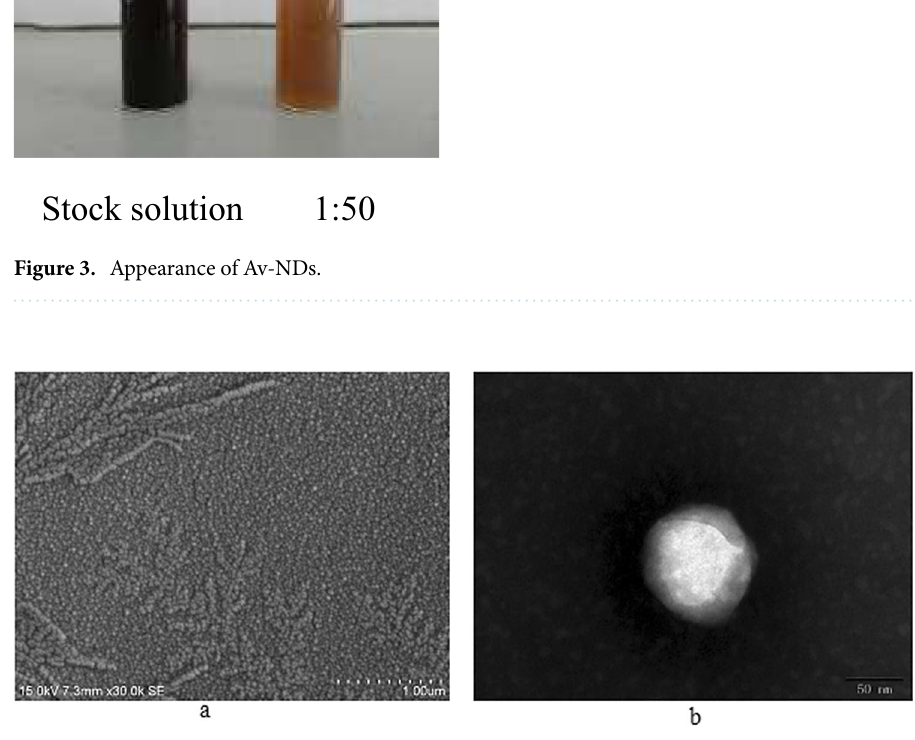
Figure 4. SEM images ( a ) and TEM images ( b ) of